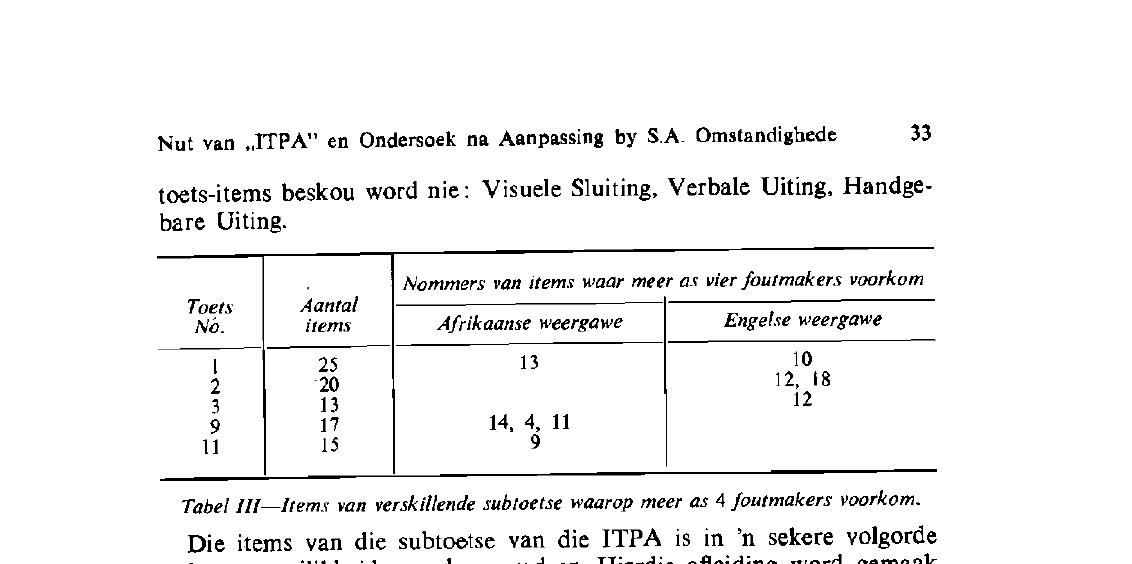
Tabel III—Items van verskillende subtoetse waarop meer as 4 foutmakers